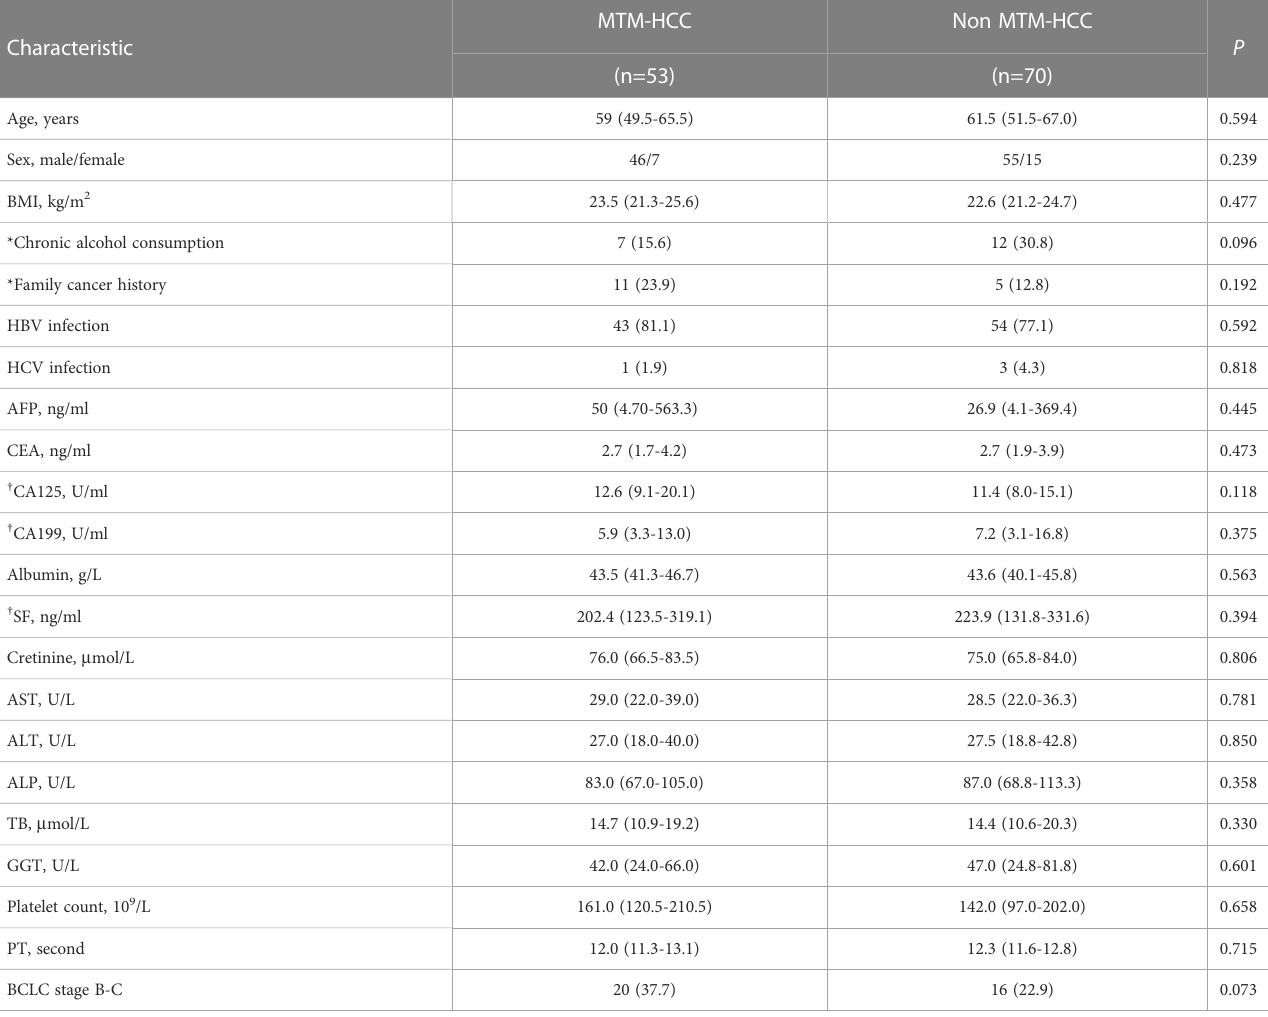
TABLE 1 Clinical and pathologic characteristics of patients with macrotrabecular-massive subtype of HCC.